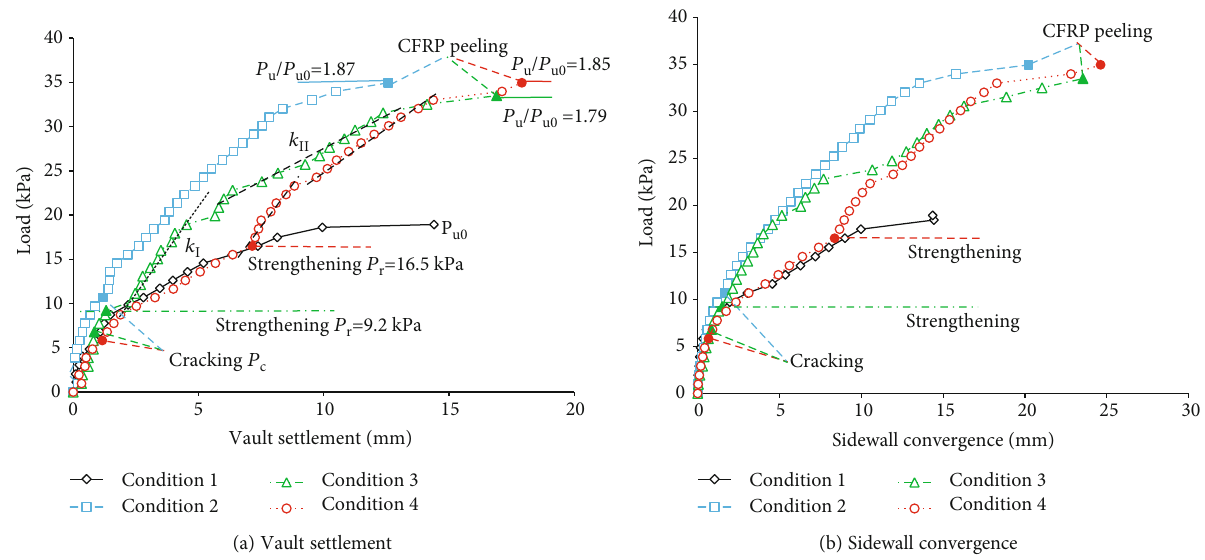
Figure 8: Curves of load-displacement with di ff erent